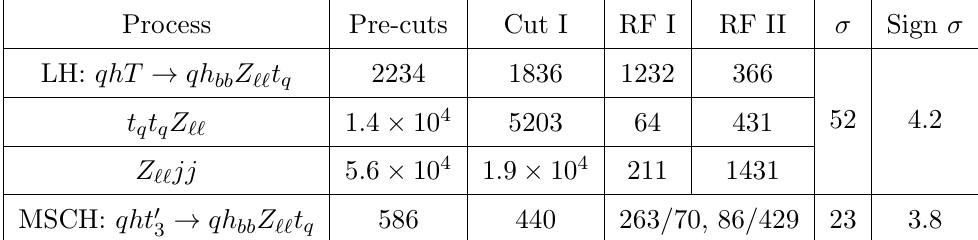
Table 6 . First four columns: signal and background event numbers in the ( ‘‘ ) + 2 j + X channel in a 30 ab (cid:0) 1 sample at a 100 TeV pp collider. Fifth column: Poisson signi(cid:12)cance [42] for discriminating signal+background model from pure background. Last column: Poisson signi(cid:12)cance for discrimi- nating signal+background models with \correct" and \wrong" signs of Y TTh . For MSCH, we list the number of signal/total background events in the RF I and RF II signal